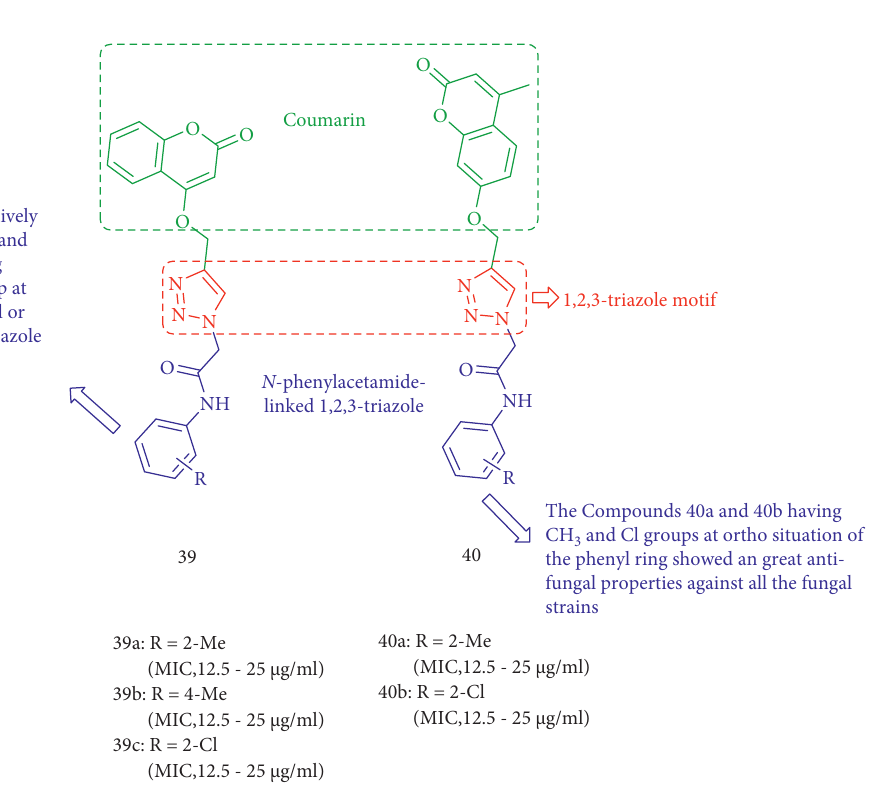
Figure 3: Chemical structure of new N-phenylacetamide-linked 1,2,3-triazole-coumarin